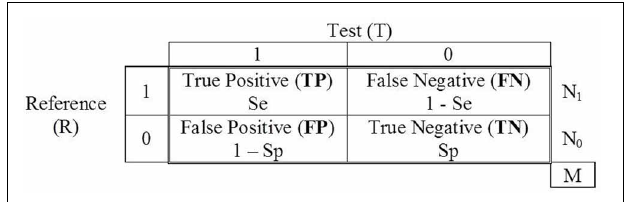
FIGURE 1 | Contingency table of the binary classifications of a reference (R) and a test (T).